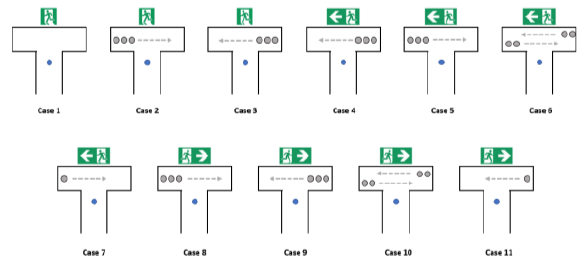
Figure 2. Case setup for scenario